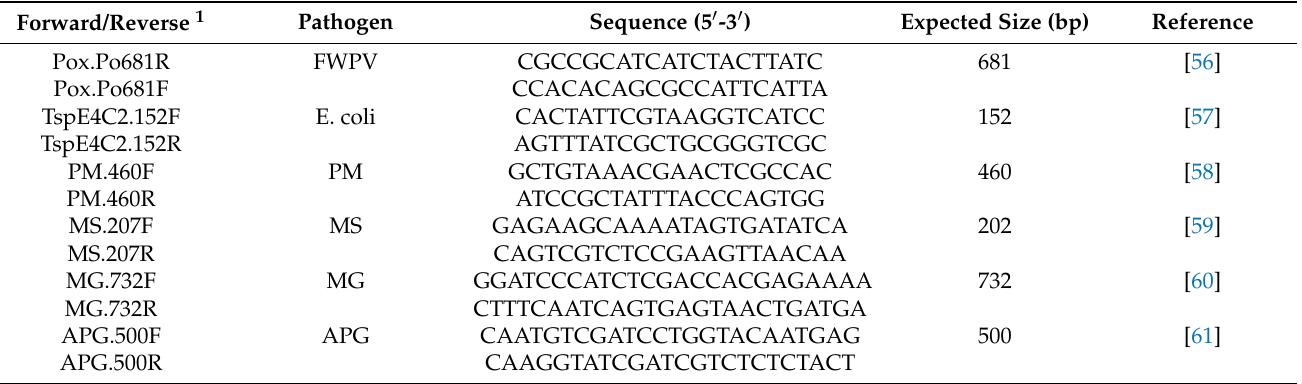
Table A2. List of primers used to detect pathogens in the specificity